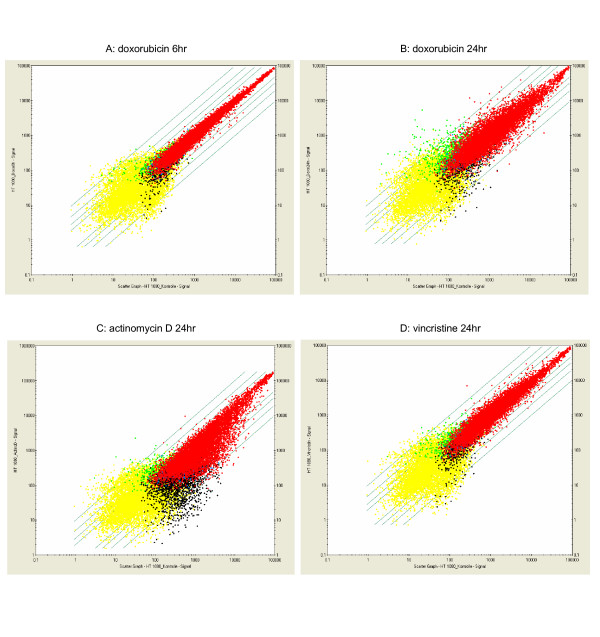
A-D: Induction of HT1080 cells by doxorubicin, actinomycin D and vincristine. HT1080 cells were treated with 0,5 μg/ml doxorubicin for 6 h or 24 h (A, B), 0.1 μg/ml actinomycin D (C) or 0.4 μg/ml vincristine (D) for 24 h. Expression profiles of the untreated control (x-axis) and the drug-induced (y-axis) HT1080 cells are shown as bivariate scatterplots of 14,500 genes from the microarray. The values are corrected intensities representing levels of expression for the DNA elements of the microarray. Colour legend: red: P-P = present in baseline (x-axis) and present in experiment (y-axis) black: P-A = present in baseline but absent in experiment green: A-P = absent in baseline but present in experiment yellow: A-A, A-M, M-A, M-M = absent or marginal in baseline or experiment